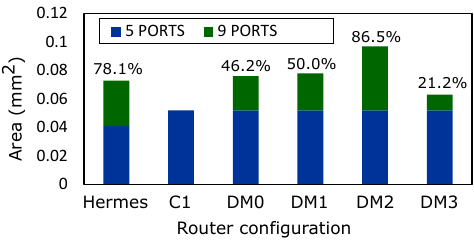
Figure 22. Router area: annotated percentages quantify the overheads introduced by additional ports.